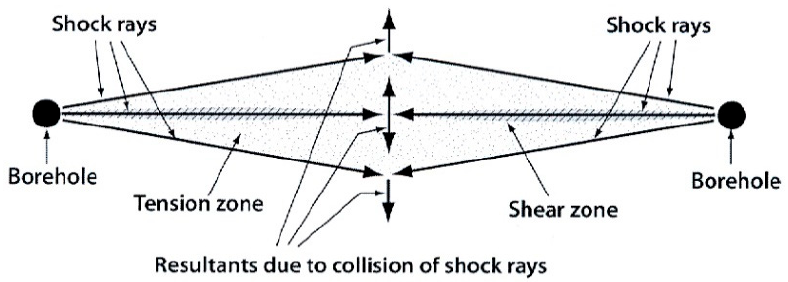
Figure 9. Schematic representation of the presplitting theory [11].